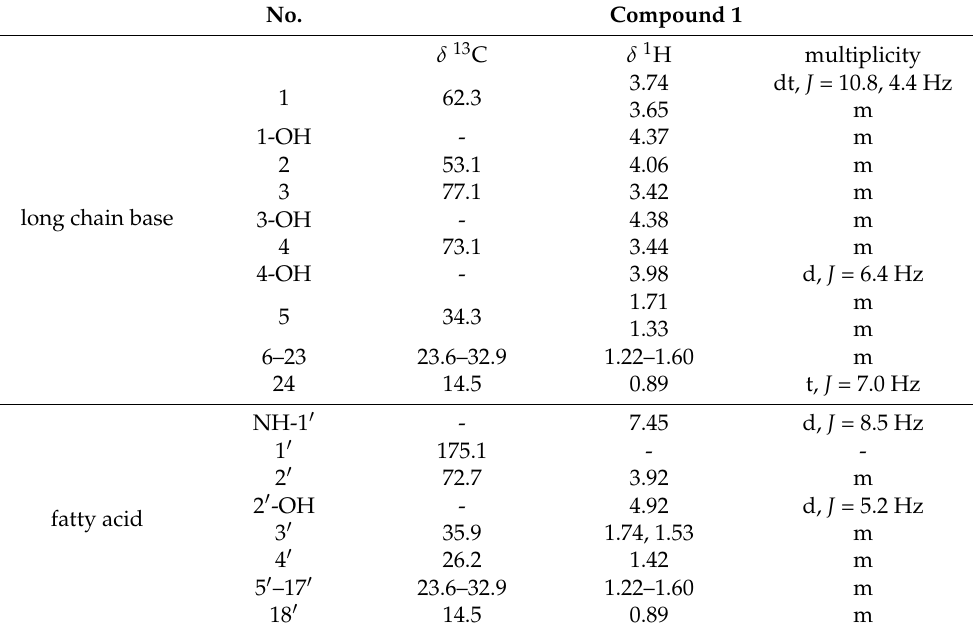
Table 1. Complete 1 H and 13 C NMR resonance assignments for compound 1 (THF- d 8